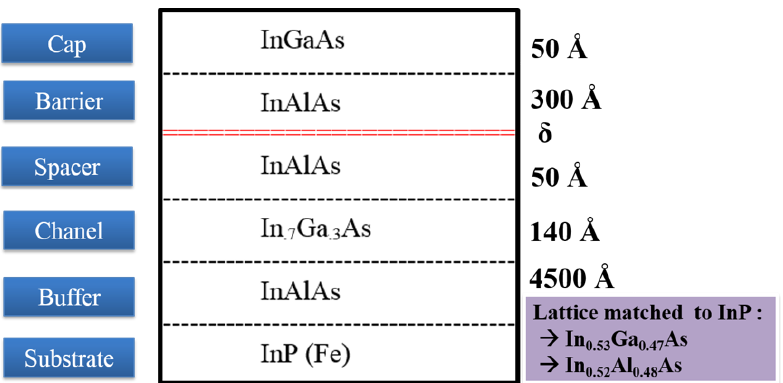
Figure 1. XMBE171 (conventional pHEMT) epitaxial layer grown on in-house RIBER V100 MBE (thickness not to scale).